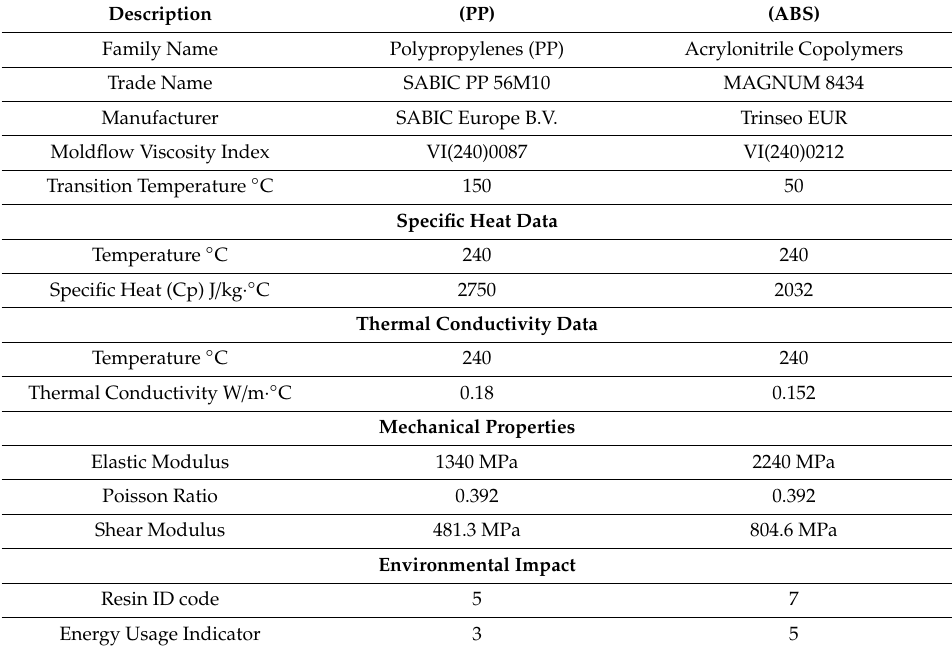
Table 2. Material properties of Polypropylene (PP) and Acrylonitrile butadiene styrene (ABS).